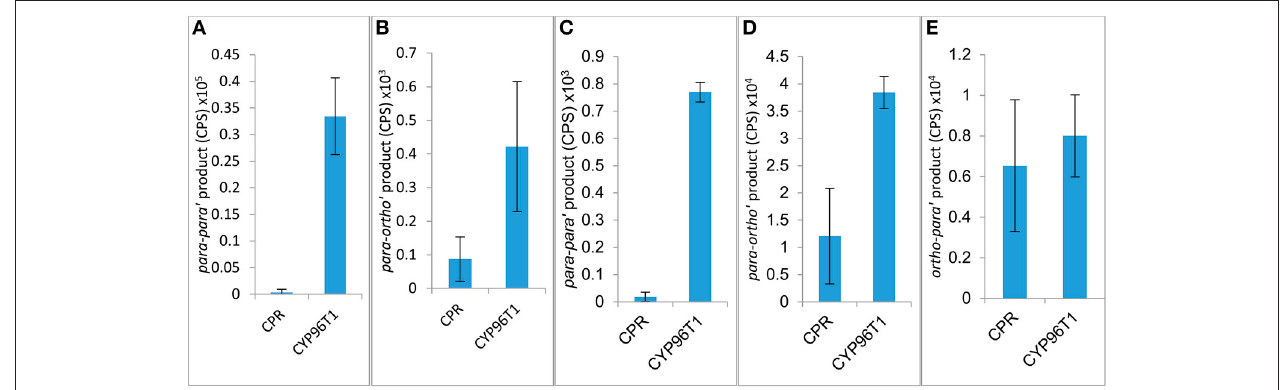
FIGURE 7 | Relative product formed in assays with 4 ′ - O- methylnorbelladine (A,B) or 4 ′ - O -methyl- N -methylnorbelladine (C,D,E) as substrate. Assays are performed in triplicate only expressing CPR or with CPR in combination with CYP96T1 . (A) para-para’ [(10b R ,4a S )- and (10b S ,4a R )-noroxomaritidine] product. (B) para-ortho’ ( N -demethylnarwedine) product. (C) Potentially para-para’ C-C phenol coupling (unknown 1) product. (D) para-ortho’ (Narwedine) product. (E) Potentially ortho-para’ C-C phenol coupling (unknown 2) product.